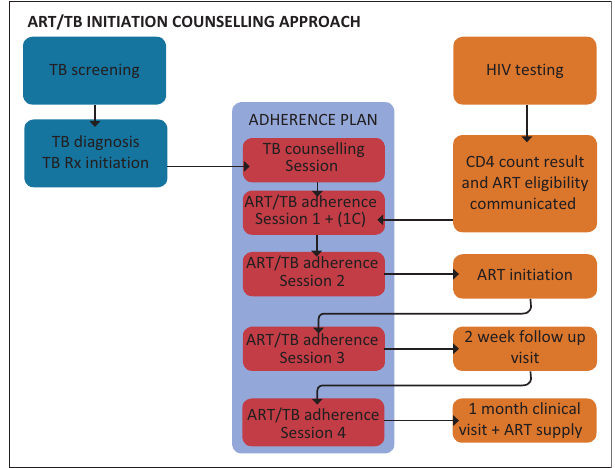
FIGURE 1: Timing of counselling